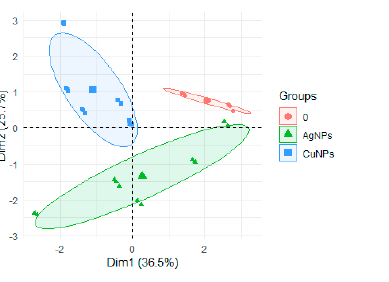
Figure 6 PCA for different chemical compounds (AgNO 3 , AgNPs, CuSO 4 , CuNPs) in the rainbow trout eggs and fry. 4. Discussion Choi et al. [23,24] and Jayesh et al. [25] drew attention to the antibacterial properties of silver, which was known for many years. Although no physiological significance is attributed to silver, it can be accumulated in organisms after its application. The toxicity of silver to rainbow trout was demonstrated by Al.-Bairuti et al. [26], who observed an increase in silver content in the eggs, depending on silver concentration; similar tendencies were noted by Morgan and Wood [27]. In our study, the levels of silver accumulation were also dependent on the type of chemical compound used. Higher contents of Ag in the eggs were found after an application of AgNO 3 compared to AgNPs. This is not consistent with the results of Farkas et al. [28], who indicated that Ag ions (e.g., AgNO 3 ) have a lower effect on the integrity of the membrane. It is possible that the application of Ag during egg swelling limited or even stopped the metal penetration through the chorion into the egg. However, it is likely that the amount of silver that penetrated the embryo was low, as there were no statistically significant differences in the concentration of silver in the fry. However, this may also indicate that most of the silver stayed in the chorion or the liquid and not in the embryo. The application of AgNO 3 affected the silver accumulation to a greater extent than in the case of AgNPs. Differences between the interactions of AgNO 3 and AgNPs were pointed out by Farkas et al. [28] in their study on rainbow trout hepatocytes regarding reactive oxygen species (ROS), and Gange et al. [29], who